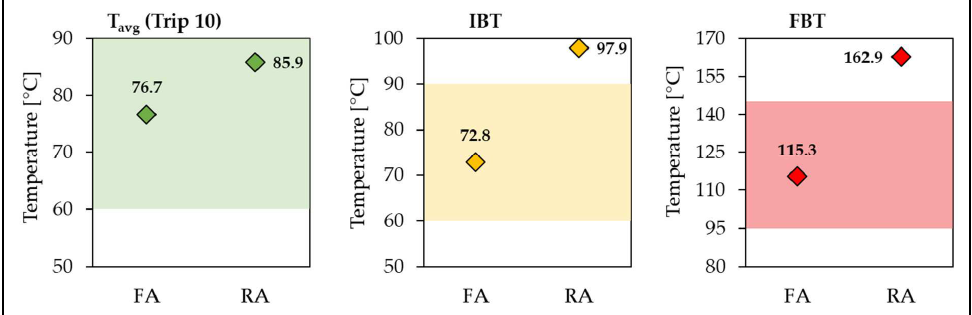
Figure 4. Temperatures of the C-segment vehicle front and rear-axle disc brakes during WLTP Brake Cycle Trip 10 cooling test. The colored background areas represent the GTR temperature corridors valid at the time the investigations were conducted.